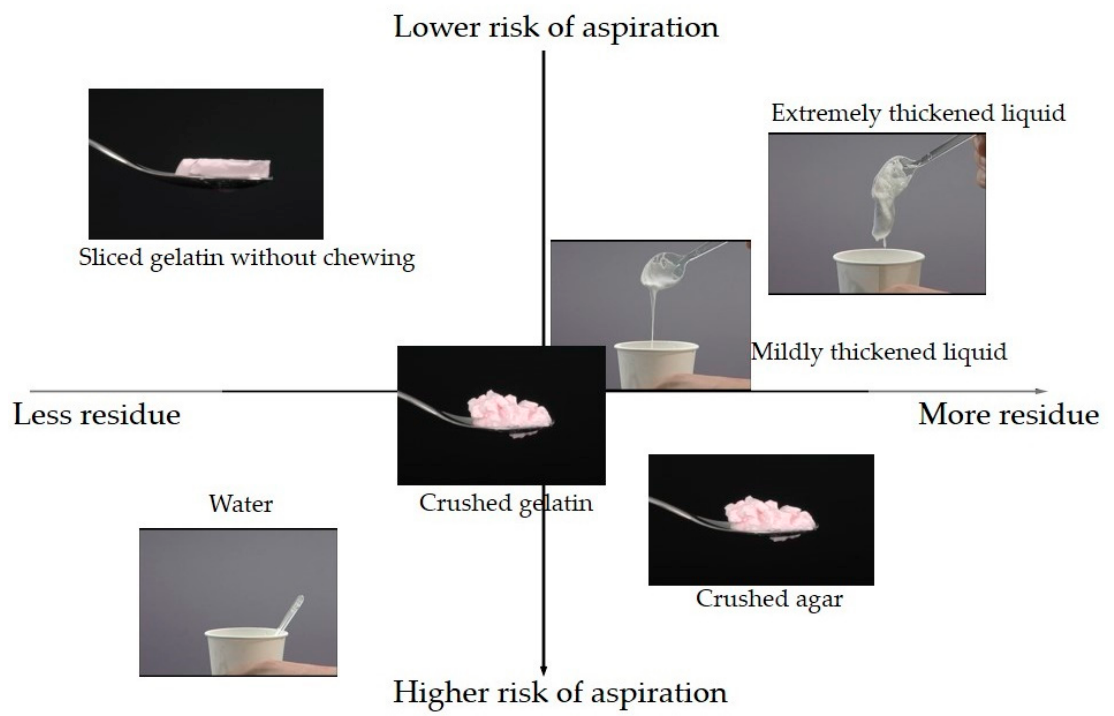
Figure 9. Tendencies of aspiration and pharyngeal residue among food types.